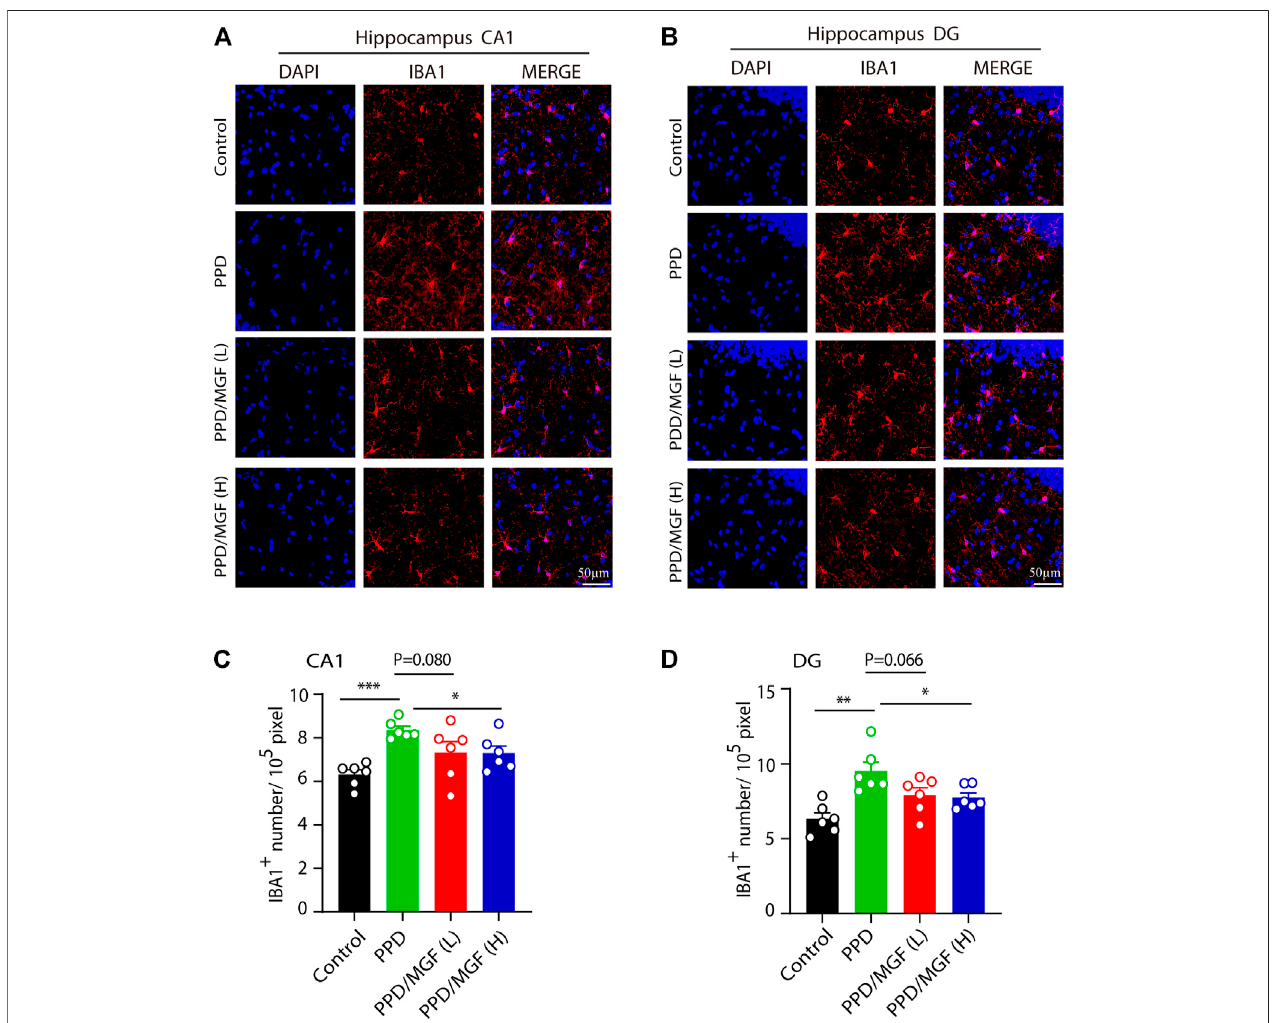
FIGURE 4 | MGF inhibited microglial numbers in vivo . (A – B) Immuno fl uorescent staining of IBA1 in CA1 and DG areas of the hippocampus. The scale bar represents 50 μ m. (C – D) Quantitative analysis of IBA1 cell numbers. Error bars are mean ± SEM. * p < 0.05, ** p < 0.01, and *** p < 0.001.